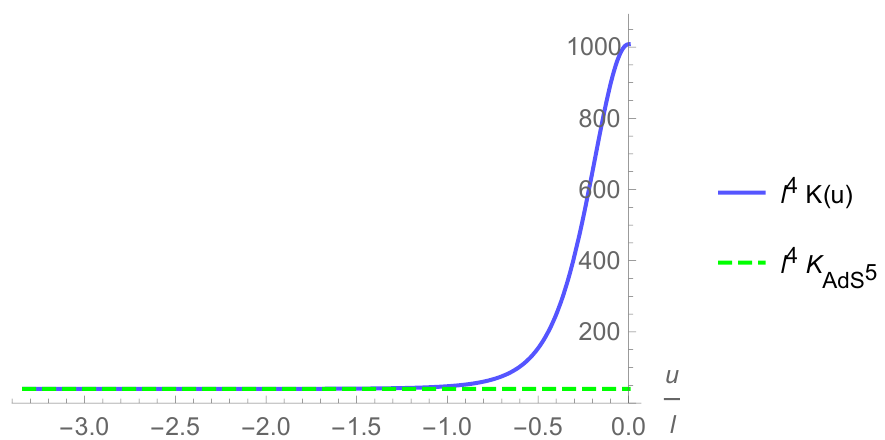
Figure 5 . The dimensionless Kretschmann scalar ‘ 4 K ( u ) = ‘ 4 R ABCD R ABCD (expressed in terms of the holographic variables in (B.5)) as a function of u for u 0 = 0. To be speci(cid:12)c we set T 2 ; 0 ‘ 2 = 20. (cid:15) When the ratio of curvatures is far from unity, increasing T ‘ 2 essentially amounts 2 ; 0 to increasing the ratio R = R 2 1